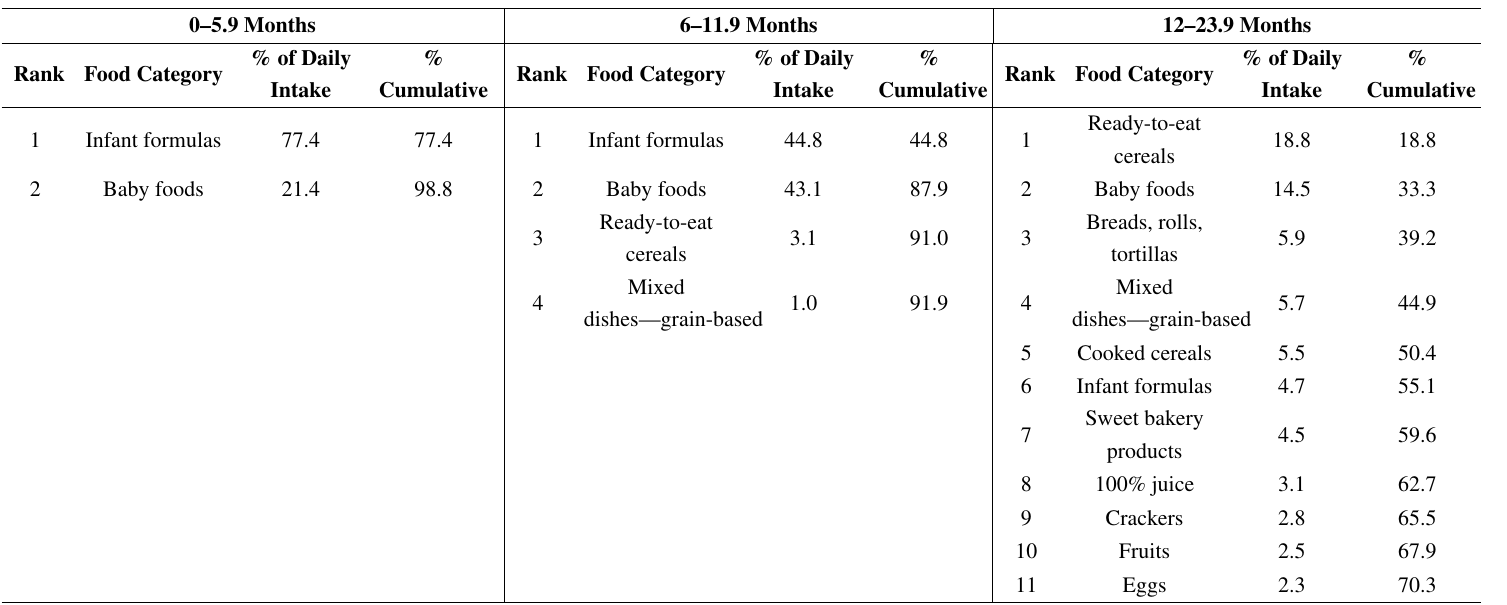
Table 17. Food sources of iron among US infants and toddlers aged 0–23.9 months by age group: NHANES 2005–2012 ( n = 2740) a